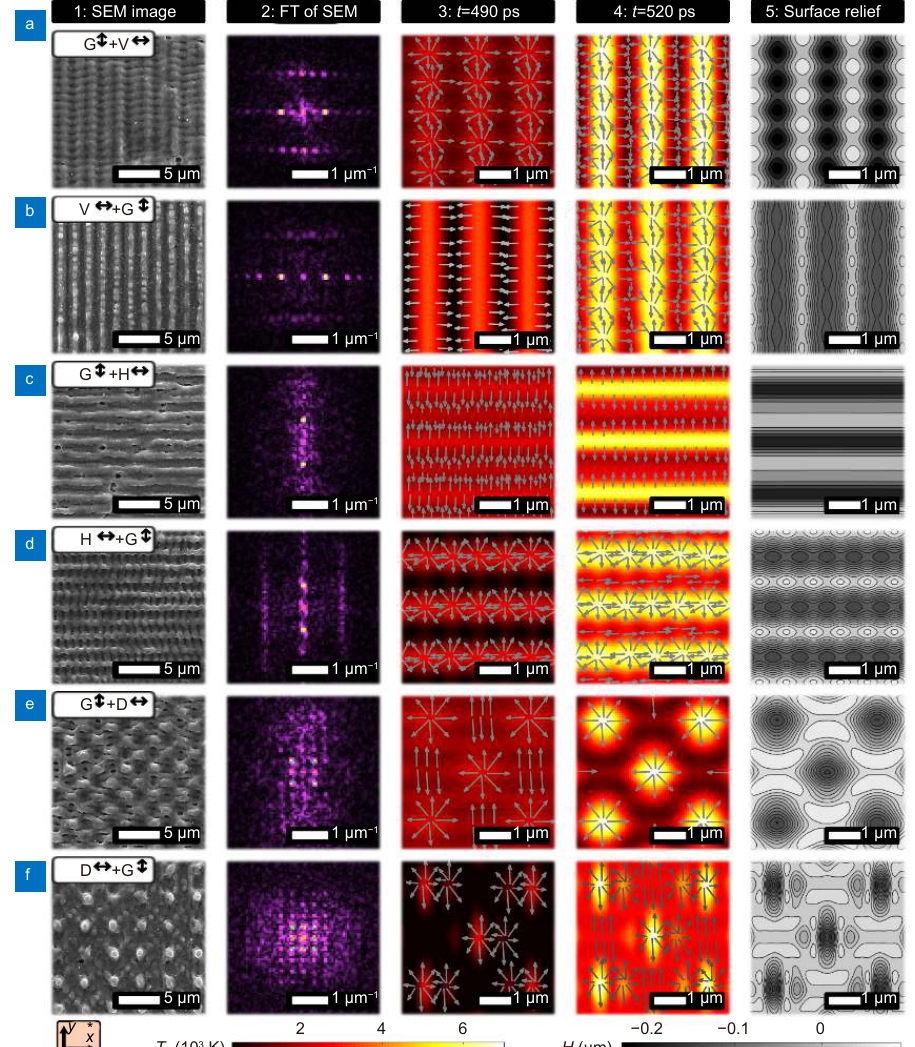
Fig. 4 | SEM images of the double pulse irradiation schemes used (1 st column) together with the respective FFT analyses (2 nd column) and simulation results (columns 3−5). The pulse profile and the order are indicated in the legends of the 1 st column, while the superscript ar- rows indicate the pulse polarization in each case. The total energy of the double pulse pair is 80 μJ/pulse and NP = 50 pulses. Simulation results are shown in each case, just before (3 rd column, Δ = 490 ps) and right after (4 th column, Δ = 520 ps) the arrival of the second pulse. The final morphology predicted by the simulation experiment is shown in the 5 th column (contour plots to illustrate the height). The arrows in the 3 rd and 4 th column provide a guide to eye representation of the fluid transport direction. The color bars at the bottom of the figure provide the temperature (3 rd and 4 th columns) and height (5 th column) values